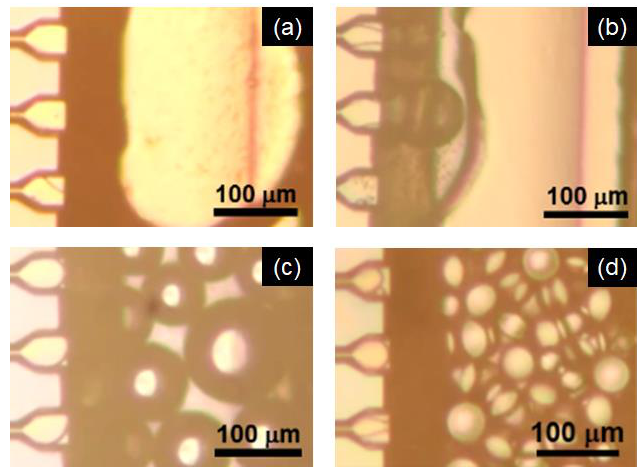
Figure 3. Droplet generation by microchannel (MC) emulsification at 60 °C with MC-A using ( a ) 0.1, ( b ) 0.5, ( c ) 1.0, and ( d ) 3.0 wt% SC as an emulsifier.